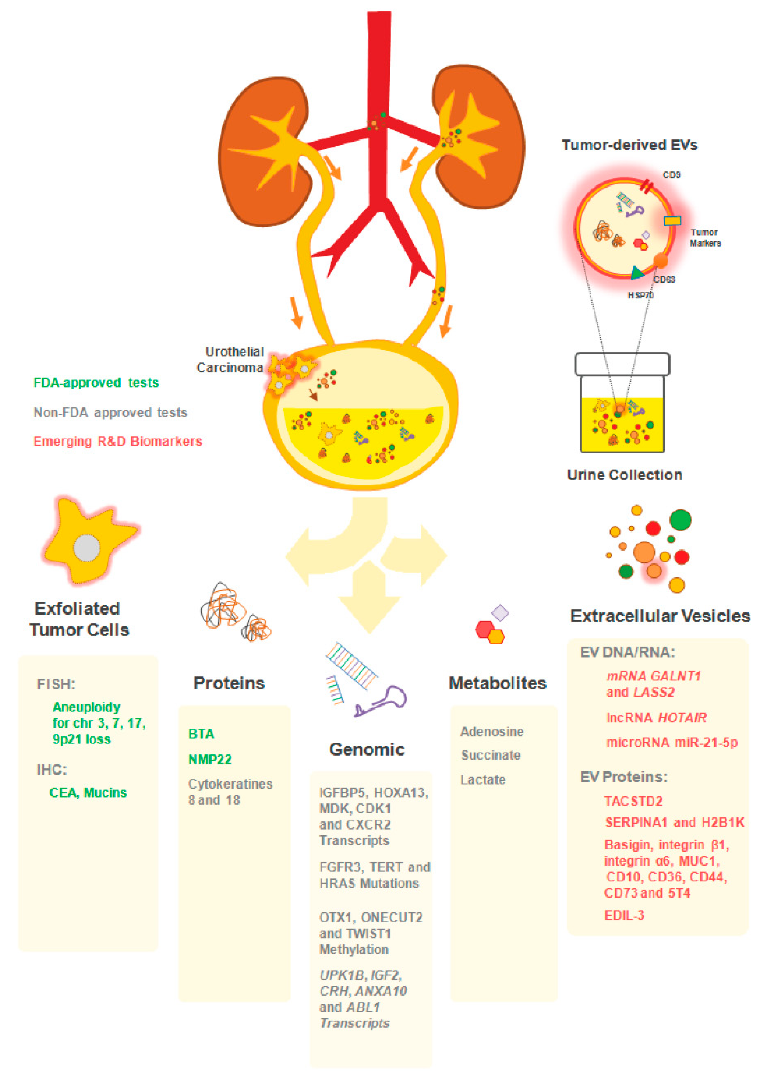
Figure 1. Urine biomarkers for bladder cancer (BCa) diagnosis and follow up. Illustration of the distinct available approaches for the detection of urothelial cancer cells in patients’ urine. The close interaction between the bladder tumor and the urine makes this body fluid a reliable source of cancer biomarkers. A plethora of non-invasive assays exploring distinct analytes (exfoliated tumor cells; proteins; genes; metabolites and extracellular vesicles) in patients’ urine allows the longitudinal analysis of tumor progression. Some of the commercially-available tests includes FDA-approved (UroVysion ™ : aneuploidy of chromosomes 3; 7; 17 and the loss of 9p21 by FISH; ImmunoCyt ™ / uCyt + ™ test: detection of carcinoembrionary antigen (CEA) and mucins by immunohistochemistry (IHC); bladder tumor antigen (BTA) TRAK / BTA Stat and NMP22 BC test kit); non-FDA approved (CxBladder ™ : IGFBP5, HOXA13, MDK, CDK1 and CXCR2 by RT-qPCR; Assure MDx ™ : FGFR3, TERT and HRAS (mutations), OTX1, ONECUT2 and TWIST1 (methylation); XPert Bladder Cancer Monitor ™ : UPK1B, IGF2, CRH, ANXA10 and ABL1 by RT-qPCR; and UBC ™ : cytokeratins 8 and 18 by ELISA) and the emerging extracellular vesicles (EV)-based biomarkers (not commercialized yet).